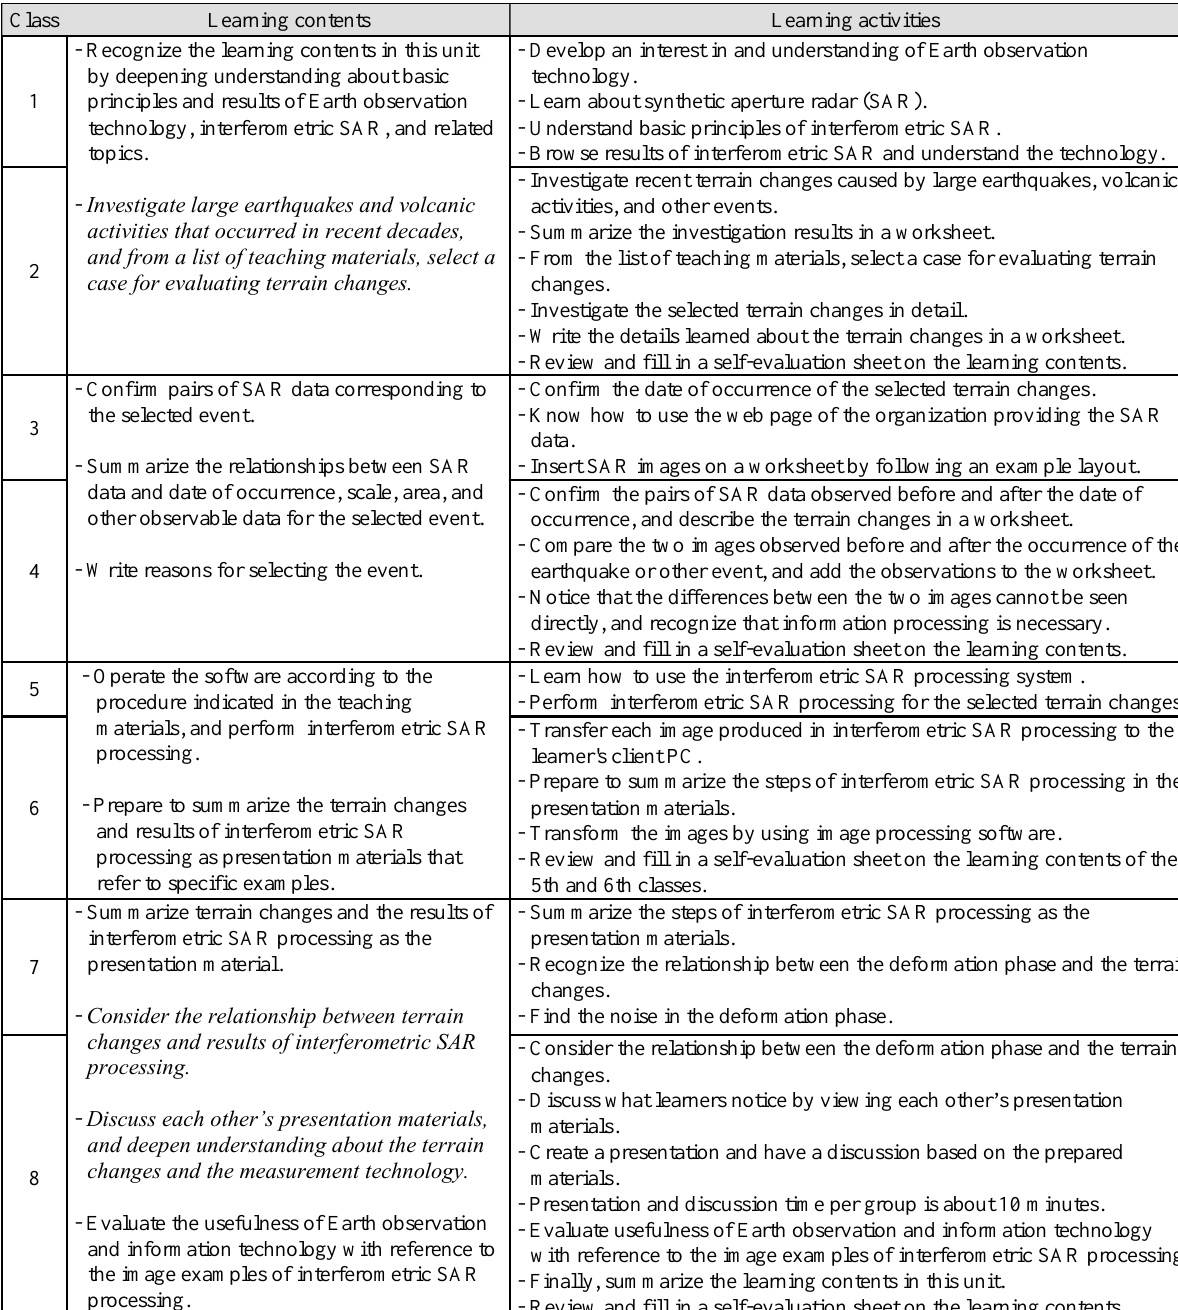
Table 1. Teaching guidance plan for science and technology education